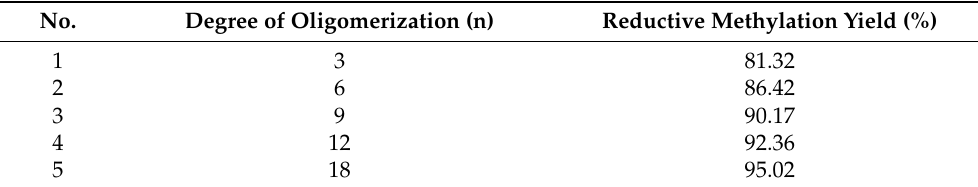
Table 1. The dependence of the reductive methylation yield of LM(EO) n AP on the degree of oligomer- ization of ethylene oxide in the polyoxyethylene chain n = 3, 6, 9, 12, 18, reaction time 90 min, molar ratio formic aldehyde/LM(EO) n AP 1.3/1, molar ratio formic acid/LM(EO) n AP 5/1, and temperature 70 ◦ C.